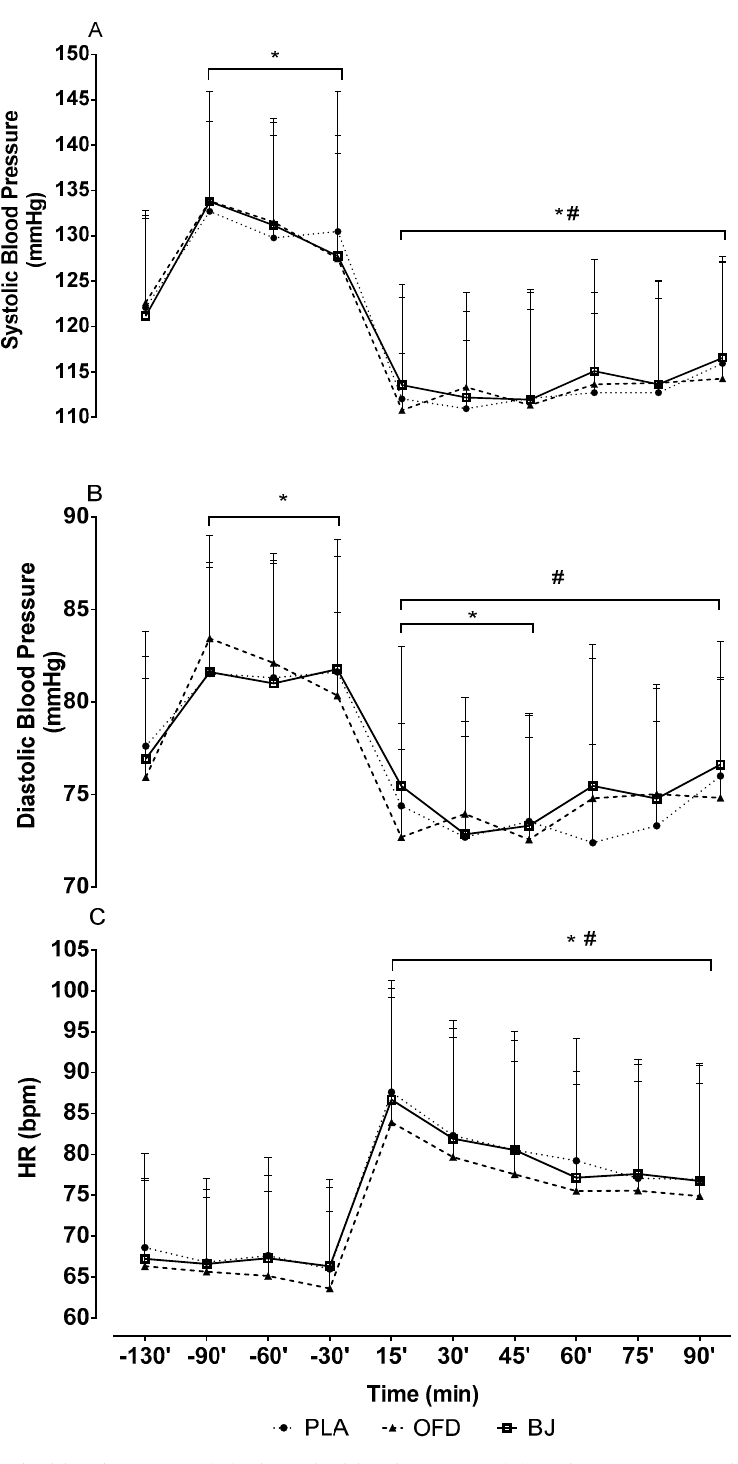
Figure 3. Systolic blood pressure ( A ); diastolic blood pressure ( B ) and point-to-point heart rate ( C ). Placebo NO 3 − depleted beetroot juice (PLA); Non-caloric orange flavor drink (OFD); Beet juice (BJ). The negative time values refer to measurements before exercise. The positive time values refer to measurements after the exercise. (*) significantly different when compared to the − 130 ′ timepoint (resting pre-ingestion); (#) significantly different when compared to the − 90’, − 60’, − 30’ timepoints (post juice intake).